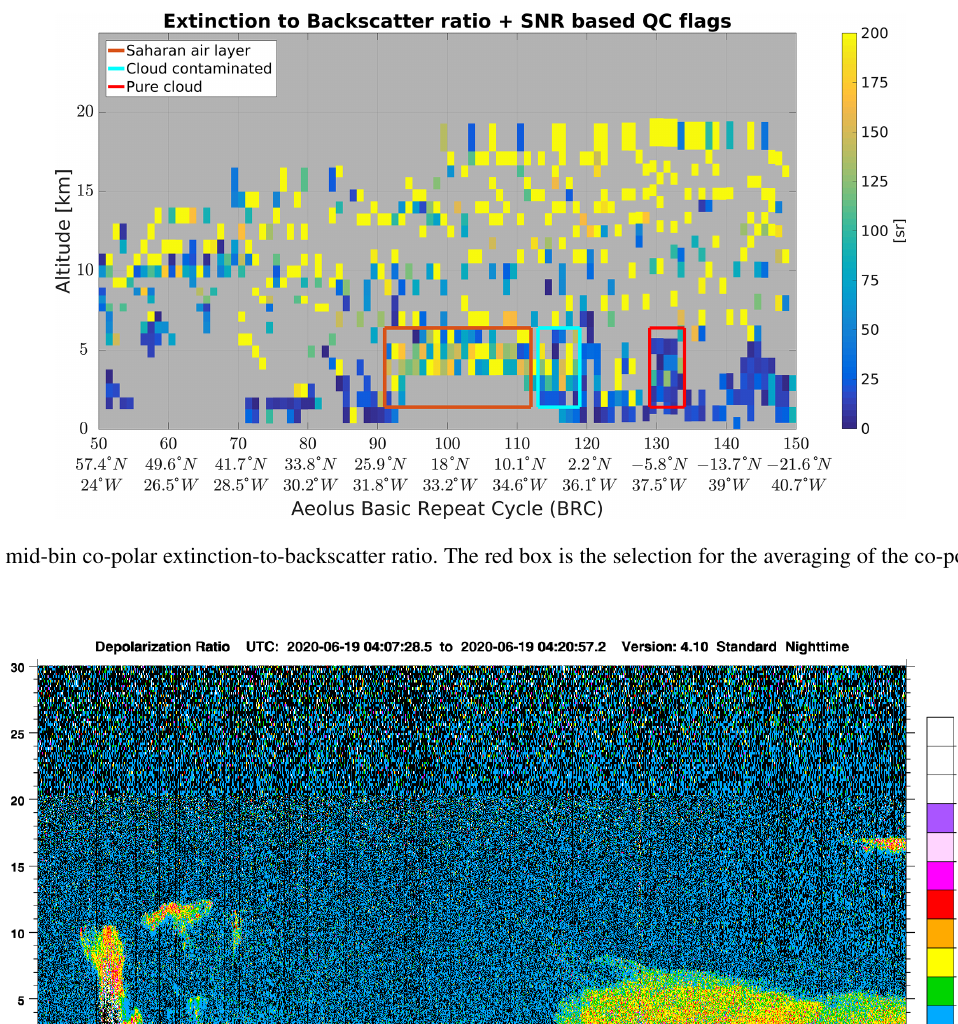
adapted calibration procedure that was made necessary